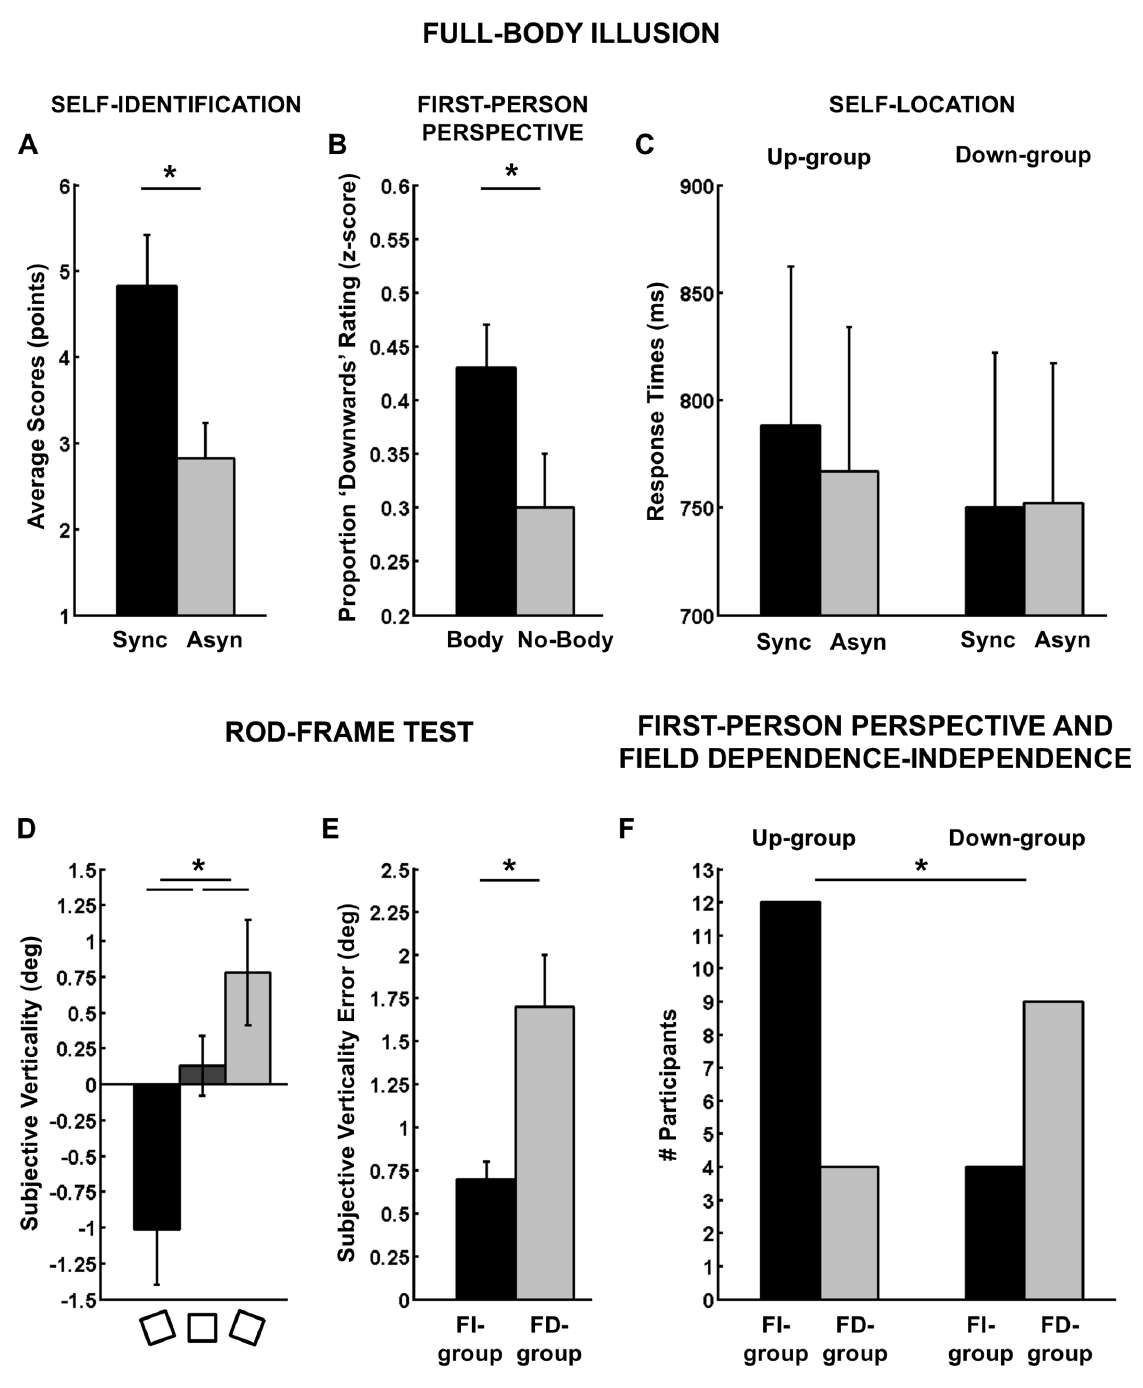
Figure 4. Results of Experiment 3. (A) Main effect of synchrony of visual-tactile Stroking on self-identification. (B) Average frequency of ‘‘downwards’’ rating for the experienced direction of the first-person perspective for the virtual body and no-body control condition. (C) Self-location results showing a similar pattern as Experiment 1 and 2. (D) Average subjective verticality rating for different frame orientations. Negative (positive) values denote counterclockwise (clockwise) deviations of the subjective verticality. (E) Average subjective verticality error in field independent (FI- group) and field dependent (FD-group) participants. Error bars denote standard errors of mean. (F) Association between Field dependence- independence and direction of the first-person perspective. doi:10.1371/journal.pone.0061751.g004 frame test. These differences, also referred to as perceptual styles rely mostly on an allocentric (i.e. visual) frame of reference, or sensory strategies, have been related to idiosyncratic selection of whereas FI participants will rely mainly on an egocentric (i.e. spatial frames of reference for spatial perception and orientation body-centered) frame of reference. The correlation between the [45]. According to this view, we predicted that FD participants will visual field dependence-independence and the experienced di-